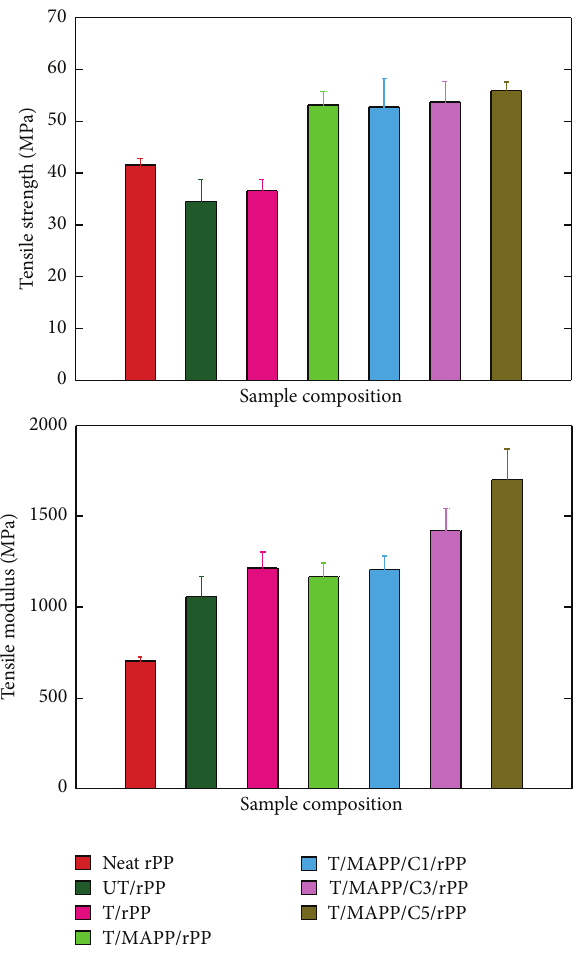
Figure 3: Tensile strength and tensile modulus of sisal fiber and nanoclay reinforced polypropylene composites.